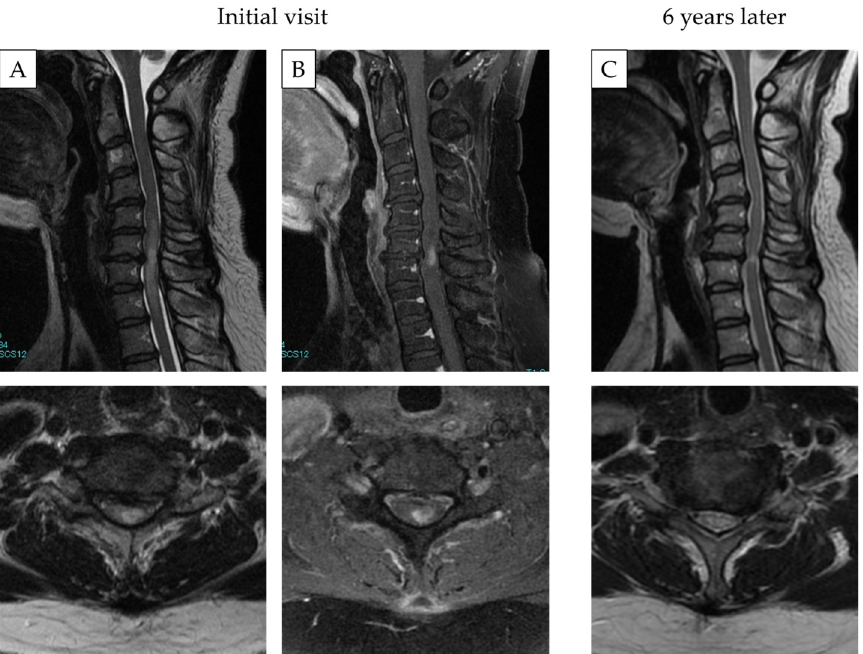
Figure 4. Representative MRI images of patient with cervical spondylotic myelopathy. Gadolinium- enhanced T2-( A ) and T1-weighted MRI ( B ) at the initial visit. The lesion site was at the C6/7 level. ( C ) T2-weighted MRI after 6 years. Signal intensity was still noted.